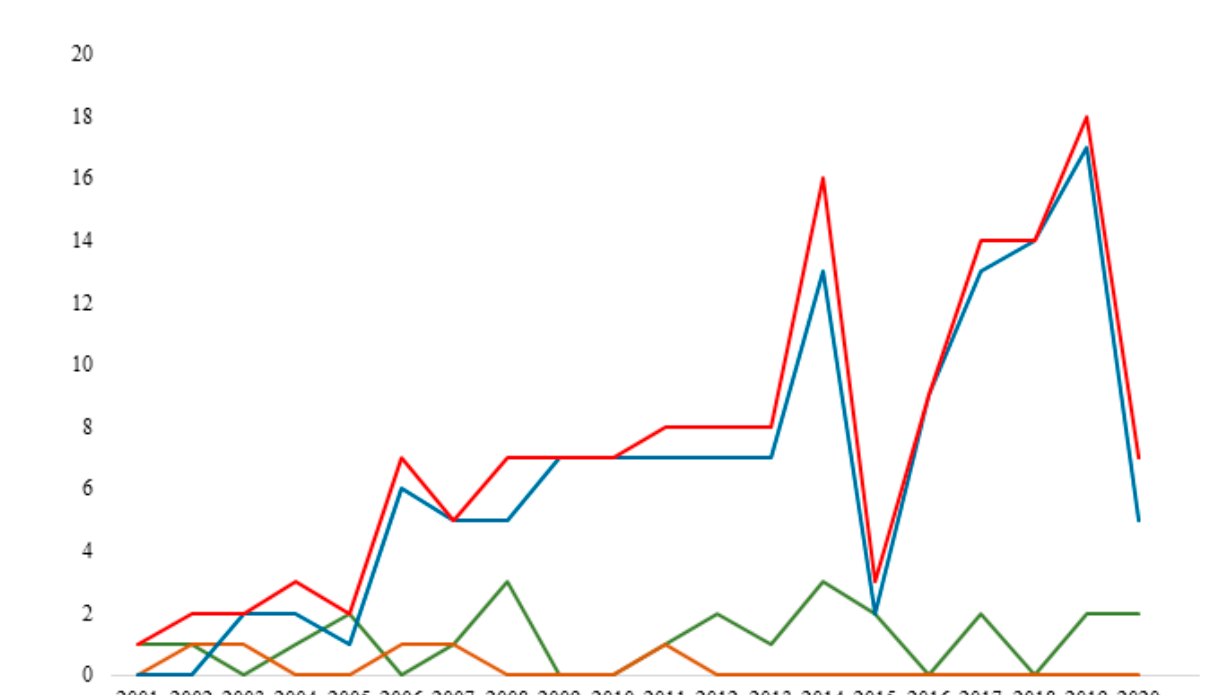
Figure 2. Number of publications through the years (2000–February 2021). The total number is indicated in red, and the other colored lines indicate the number of publications according to each detection method used (serology, microscopy, or molecular